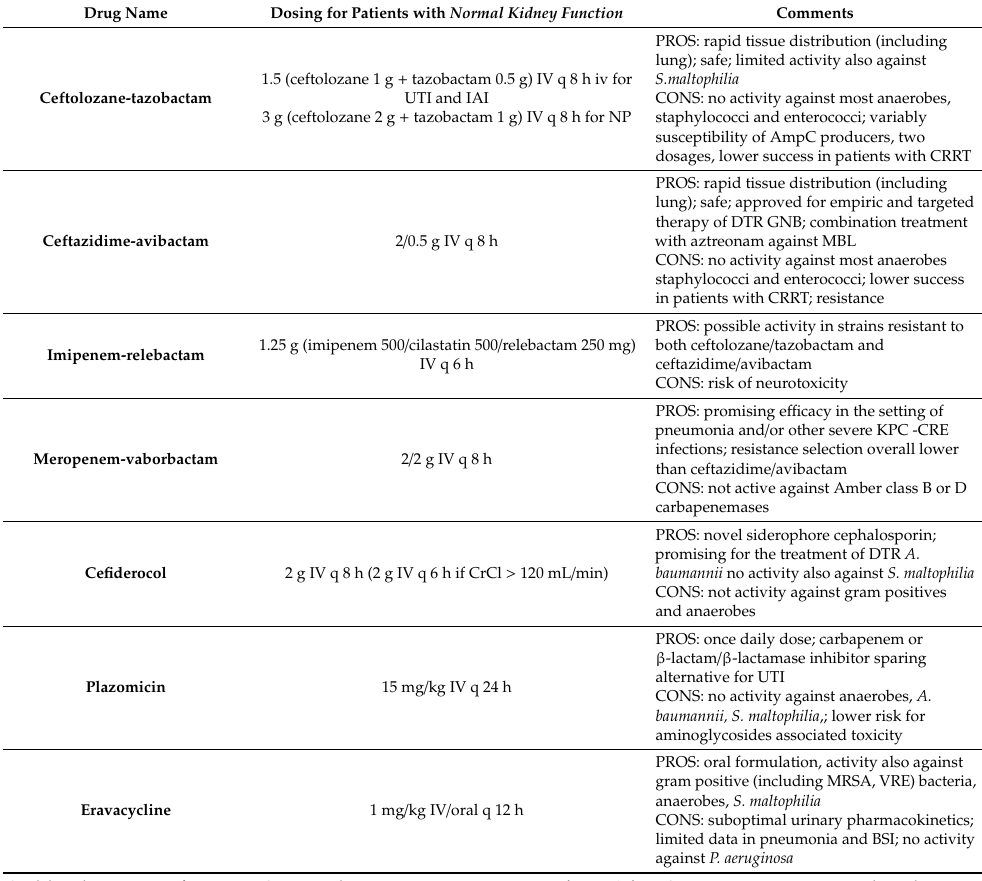
Table 3. New antibiotics for DTR-GNB currently approved with dosing, pros and cons. Drug Name Dosing for Patients with Normal Kidney Function